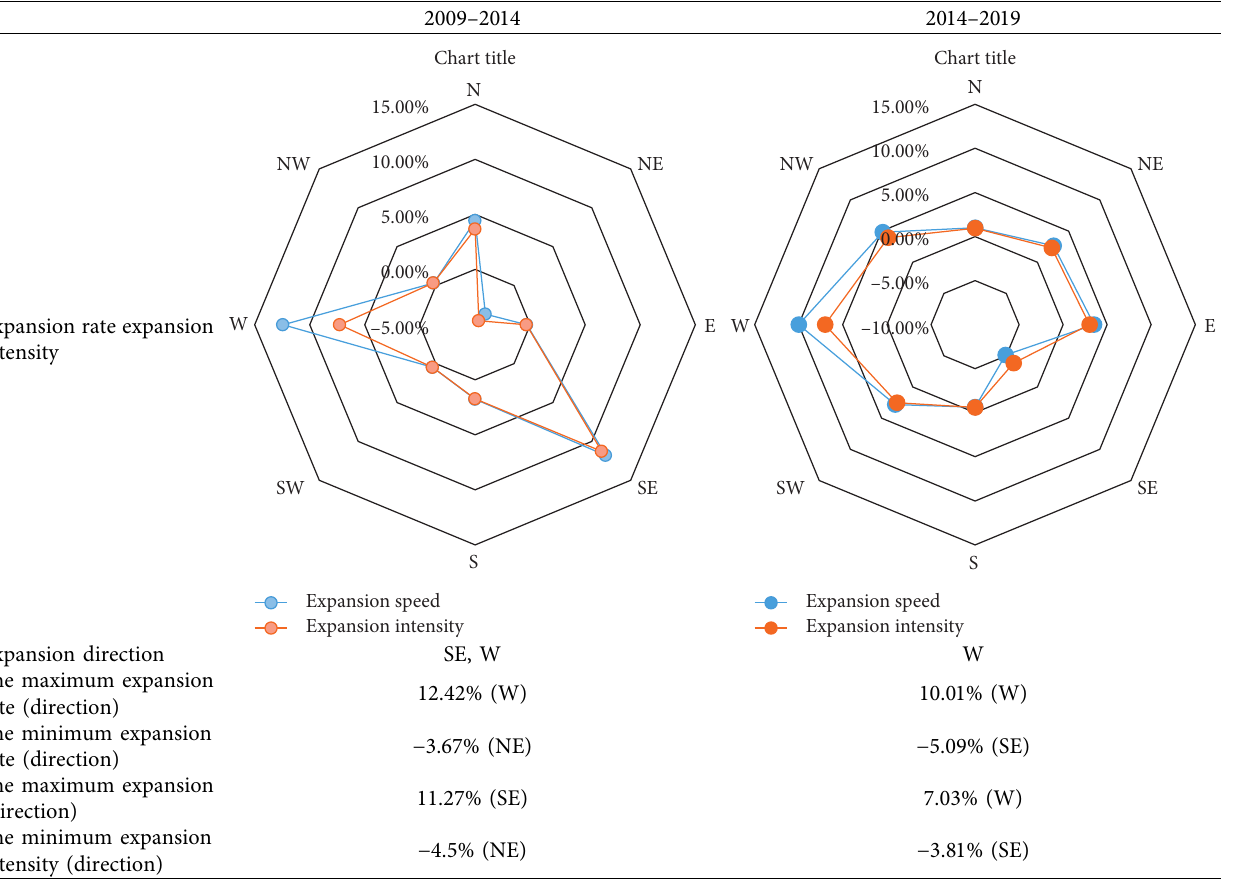
Figure 2: Radar chart of town construction land expansion from 2009 ‒ 2019. Table 6: Directions of construction land expansion in Ciyutuo Subdistrict from